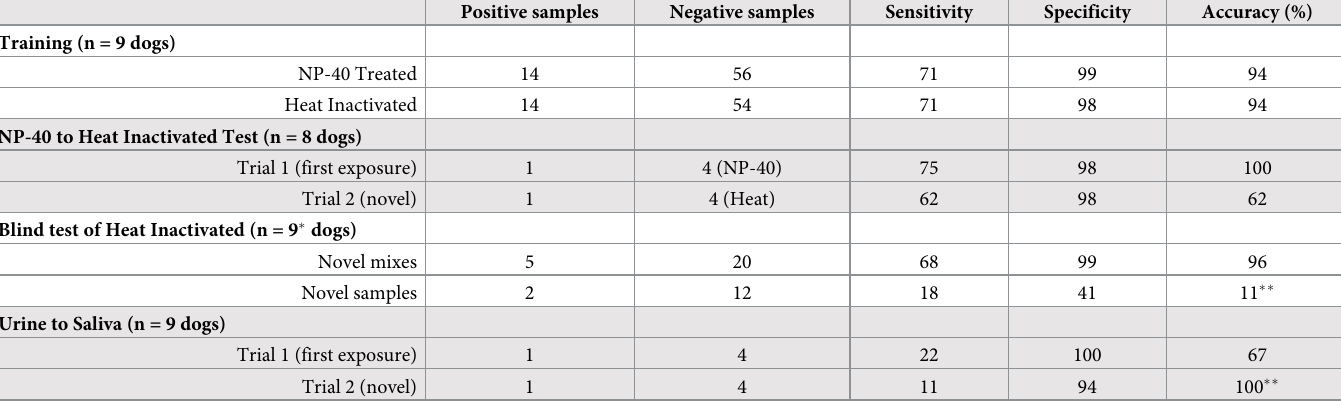
Table 4. Total number of positive samples presented, negative samples presented, sensitivity and specificity (first pass on odor), as well as accuracy, across dogs for teach training and testing